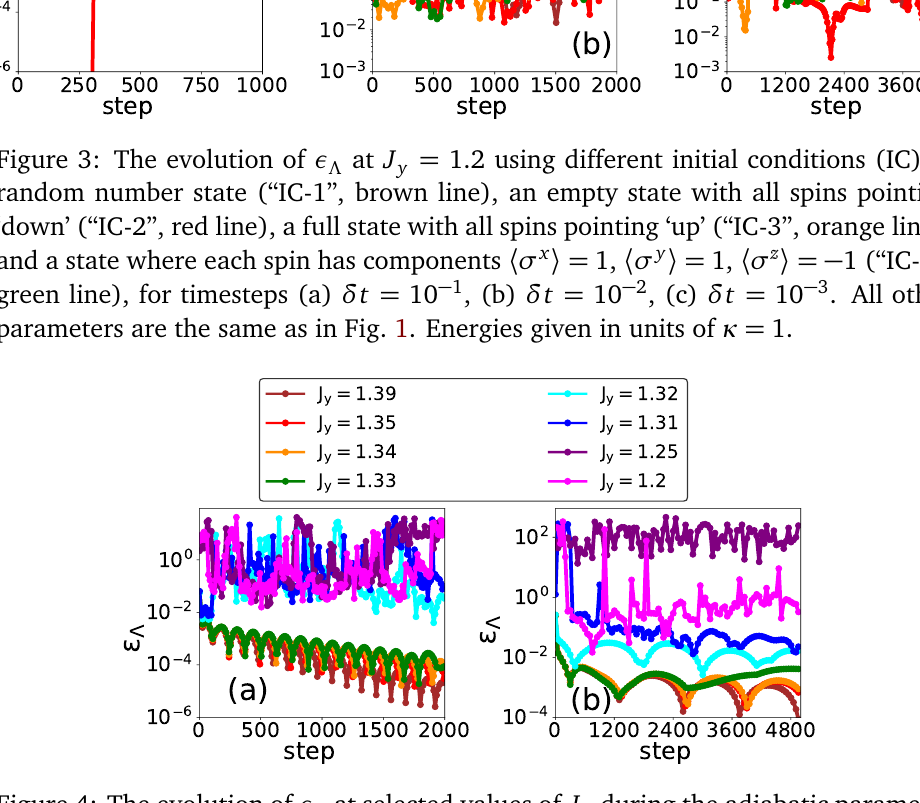
during the adiabatic parameter y = 1.2 in steps of ∆ J = 0.01 y y